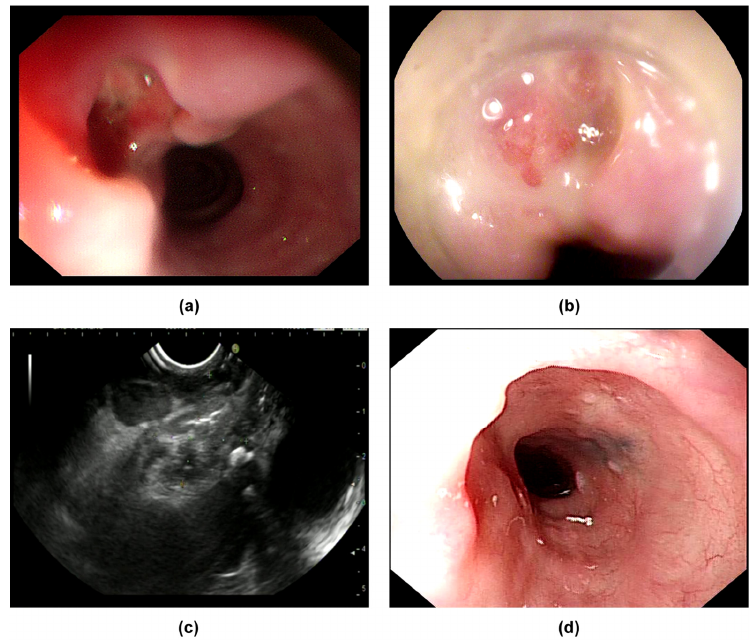
Figure 3. Manifestations of Case 4: ( a , b ) manifestations of the lesion according to EGD; ( c ) the lesion as shown by EUS; ( d ) changes shown by using endoscopy after drug treatment.